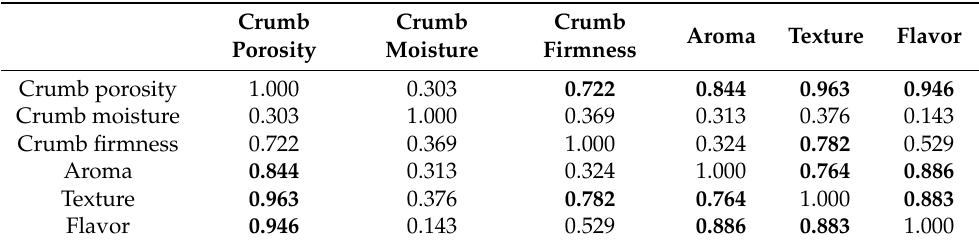
Table 2. Regression vector (RV) coefficients relating crumb porosity and the physical and sensorial properties during 72 h of